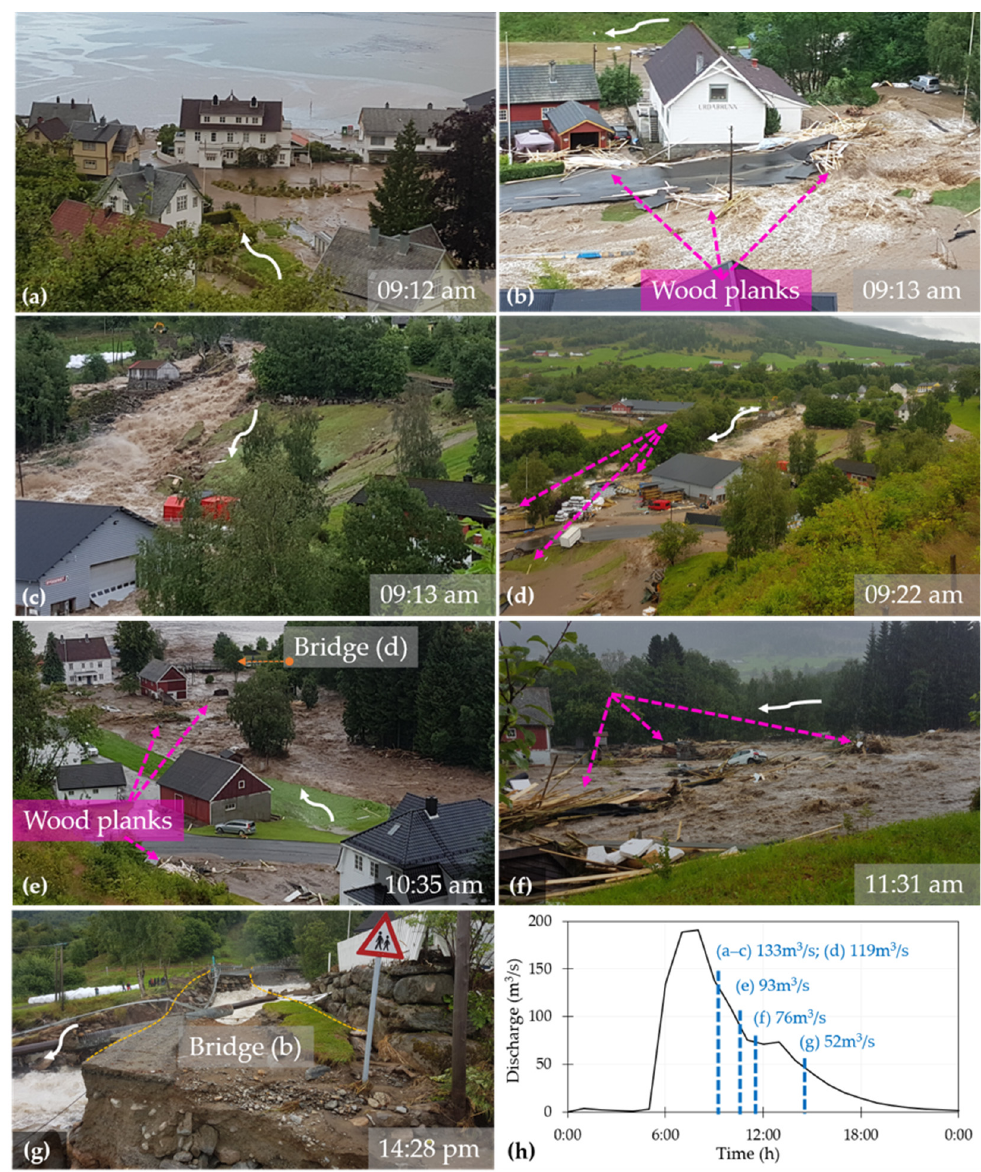
Figure 4. Examples of visual documentation of the flash flood in the Storelva river in Utvik on 24 July 2017 (( a – g ), photo- graphed by O. Bruland after Q peak ), sorted temporally and referenced in the hydrograph with highest expectancy ( h ) from 24 July 2017 (( a – g ), photographed by O. Bruland after Q peak ), sorted temporally and referenced in [8]. Flow direction indicated by white arrows. the hydrograph with highest expectancy ( h ) from [8]. Flow direction indicated by white